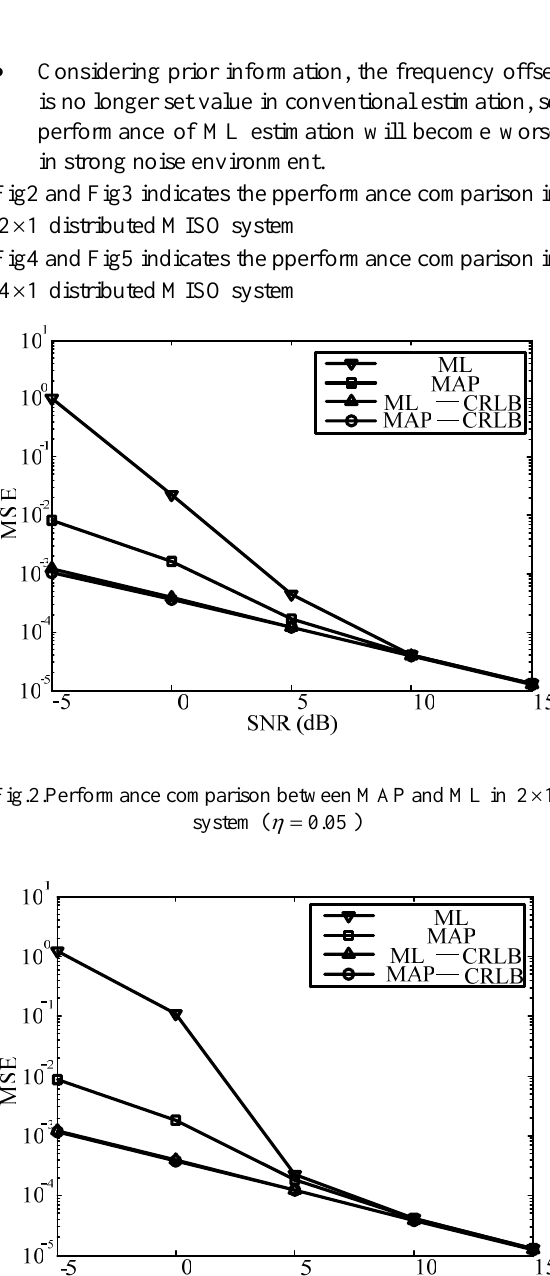
Fig.3.Performance comparison between MAP and ML in 2 1 × system